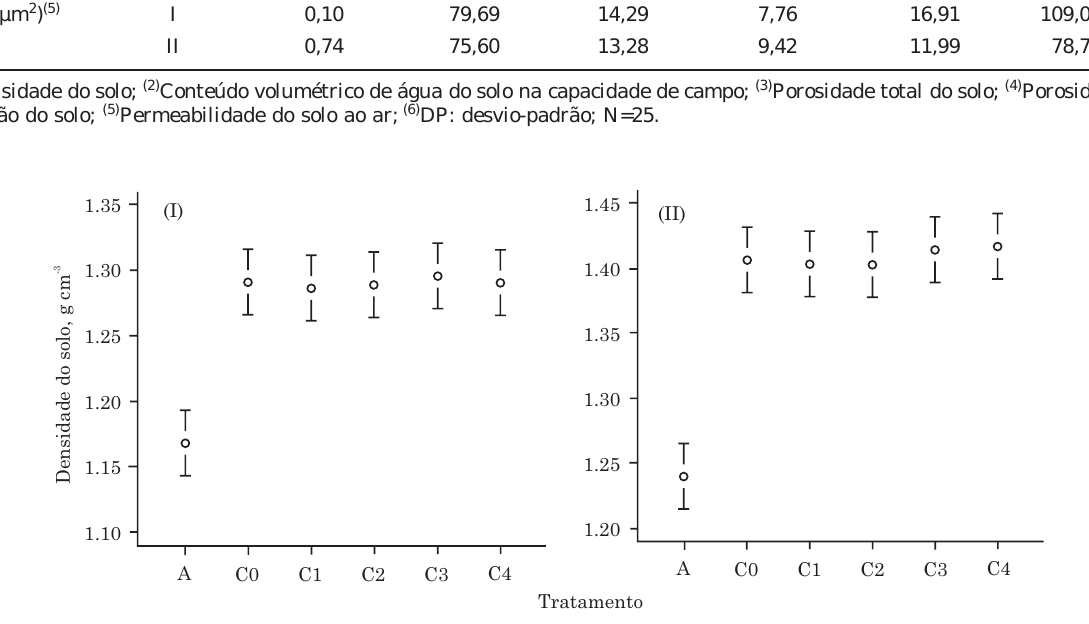
Figura 1. Valores médios de densidade de dois Latossolos Vermelhos distróficos, um argiloso (I) e um franco- argilo-arenoso (II), nos tratamentos A, C0, C1, C2, C3 e C4. As barras representam o intervalo de confiança da média (85